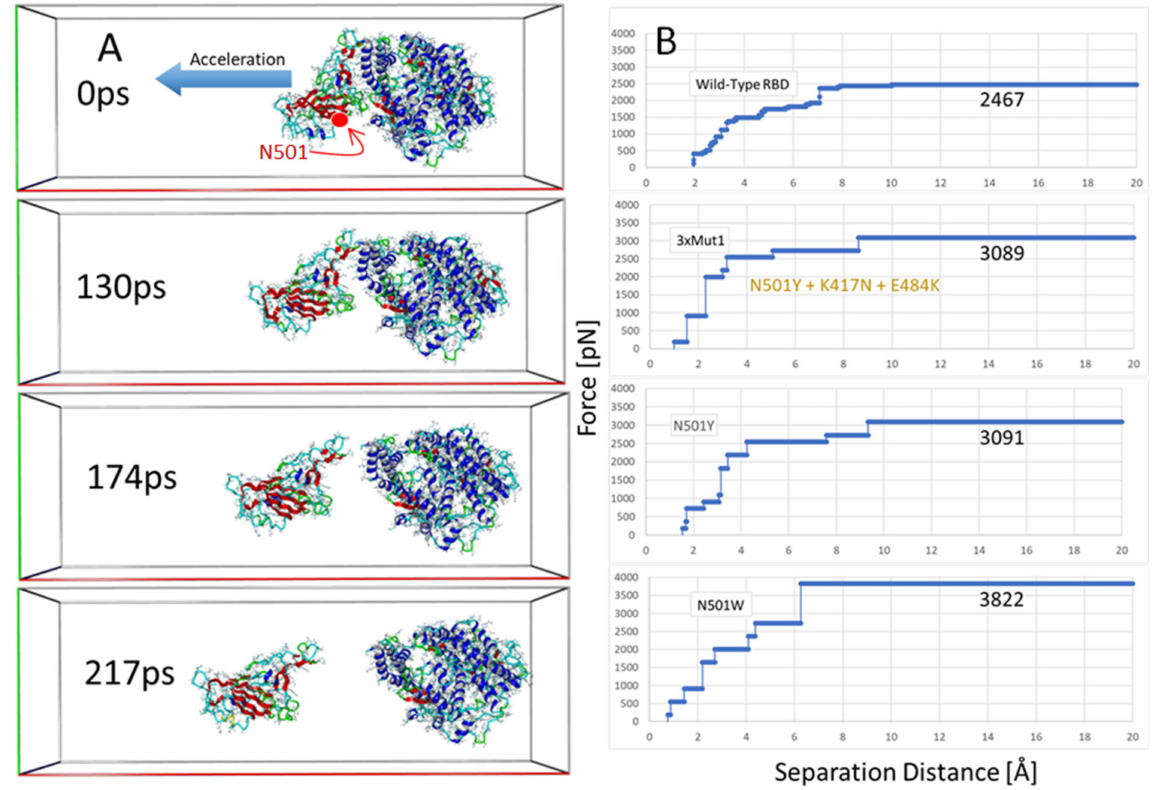
Figure 8. ( A ) Frame-captures from the SMD simulation of the wild-type RBD-ACE2 complex (6LZG) showing detachment of the RBD from the tethered ACE2 receptor. Water and NaCl ions have been hidden for clarity. Note that the lower part of the interfacial region near N501 residue locus of the RBD (red arrow) was the first area to undergo complete separation from the ACE2 receptor. The upper region of the interfacial zone furthermost from N501 was the last to undergo separation after about 160–170 ps of elapsed time. ( B ) Pulling force (pN) as a function of separation distance (Å) for the wild-type 6LZG complex (lower graph), RBD mutant N501W, RBD triple mutant 3xMut1, and RBD mutant